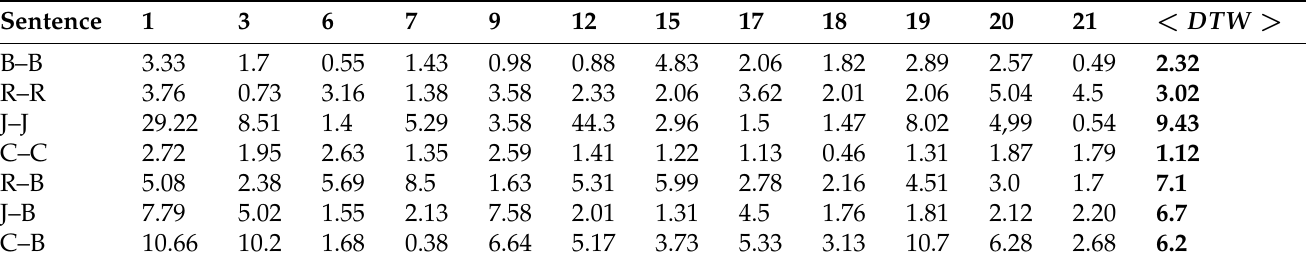
Table 5. Average individual and pairwise DTW scores.